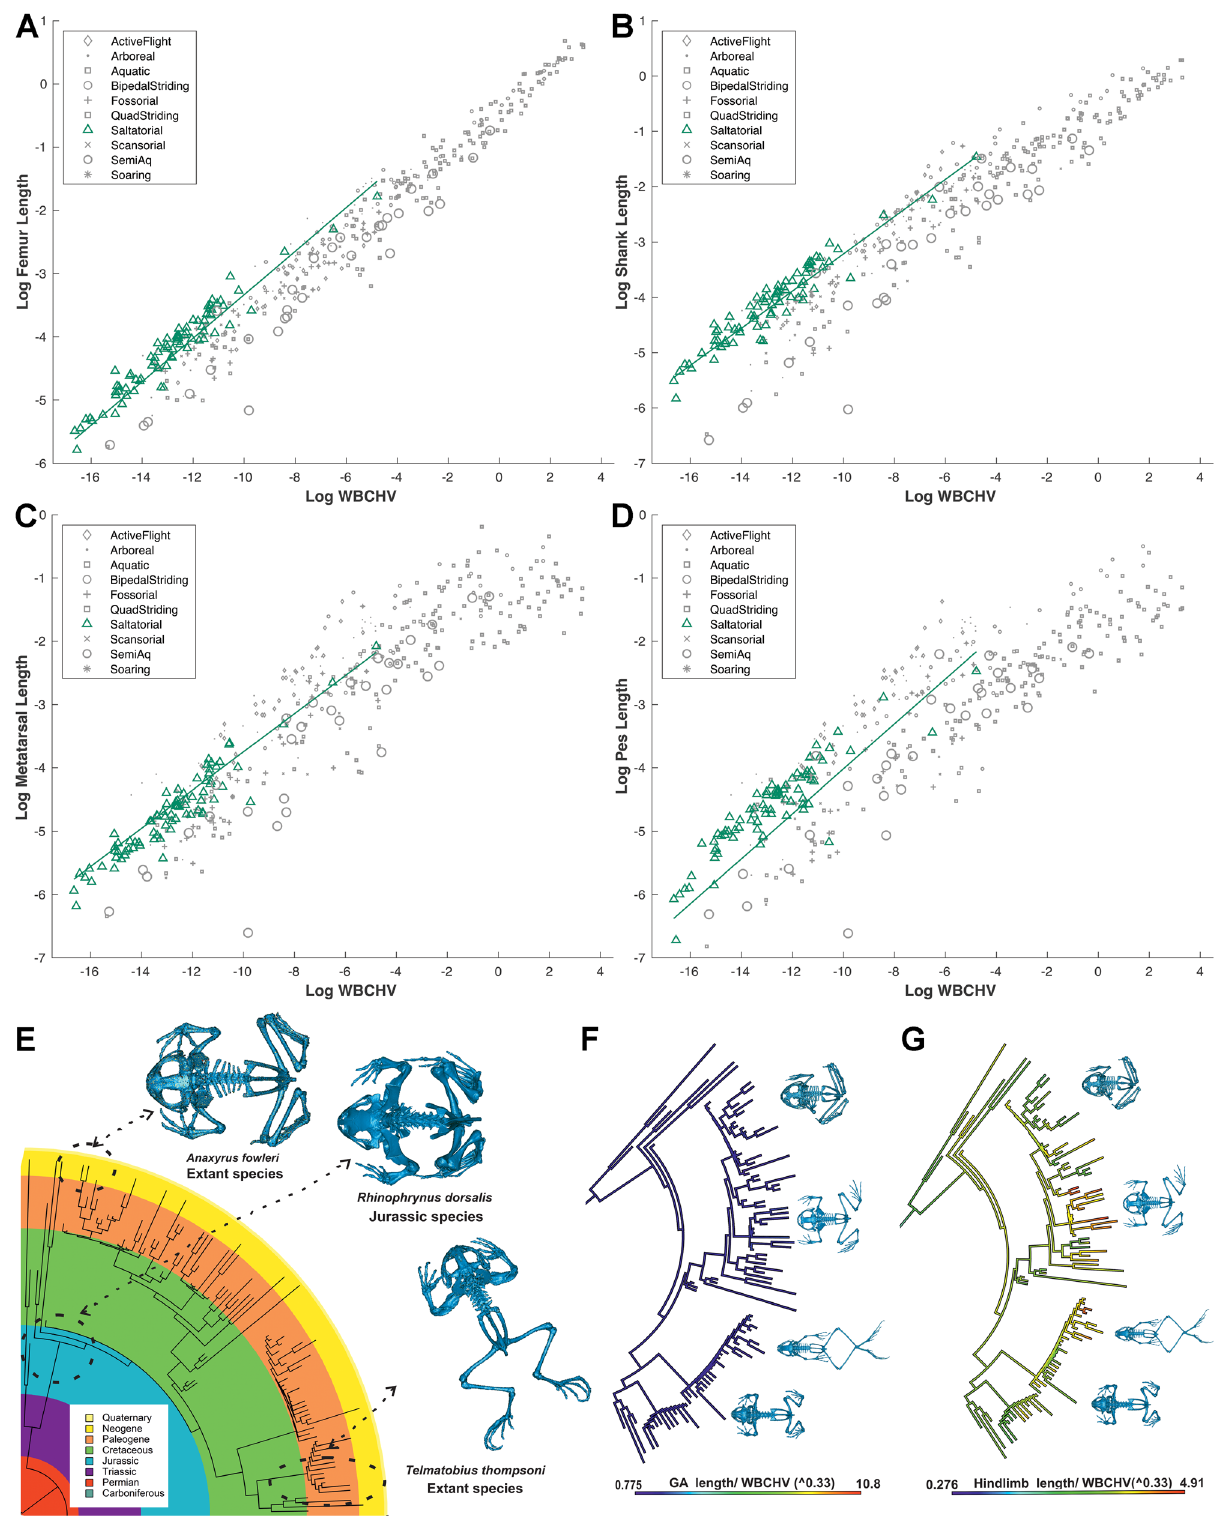
Fig. 8 | Body proportions in saltatorial tetrapods. Phylogenetic-informed regression provides support for relatively long A femur B , shank C metatarsal and D pessegmentlengthsinsaltatorialtaxacomparedtomostothertetrapod groups. Our saltatorial group is dominated by anurans, which have been hypothesised to have been conservative in their overall body proportions since the Triassic, which is qualitatively consistent with E – G visual trends in ancestral state values recovered here. This apparent conservatism underpins the low levels of variability (e.g. coef fi cients of variation; Supplementary